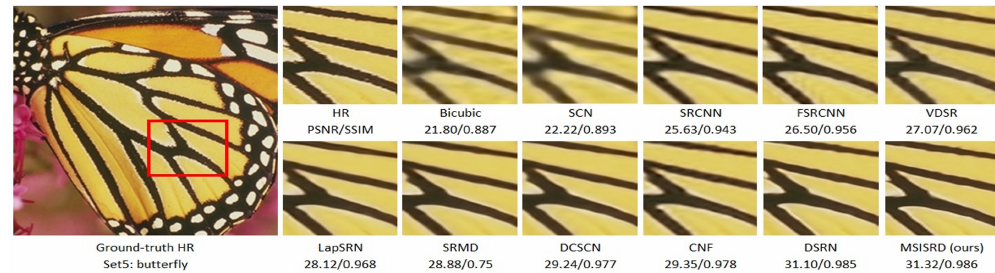
Figure 6. Visual performance of image “butterfly” of Set5 [56] dataset with 4 × scale factor enlargements [68].